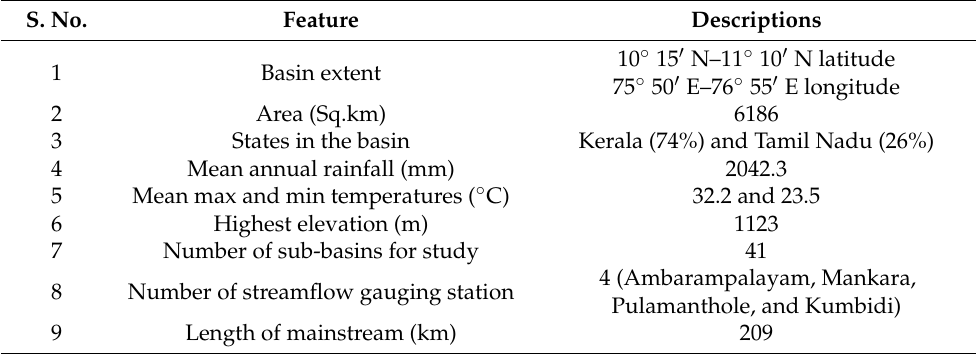
Table 1. Salient features of the BRB study area.